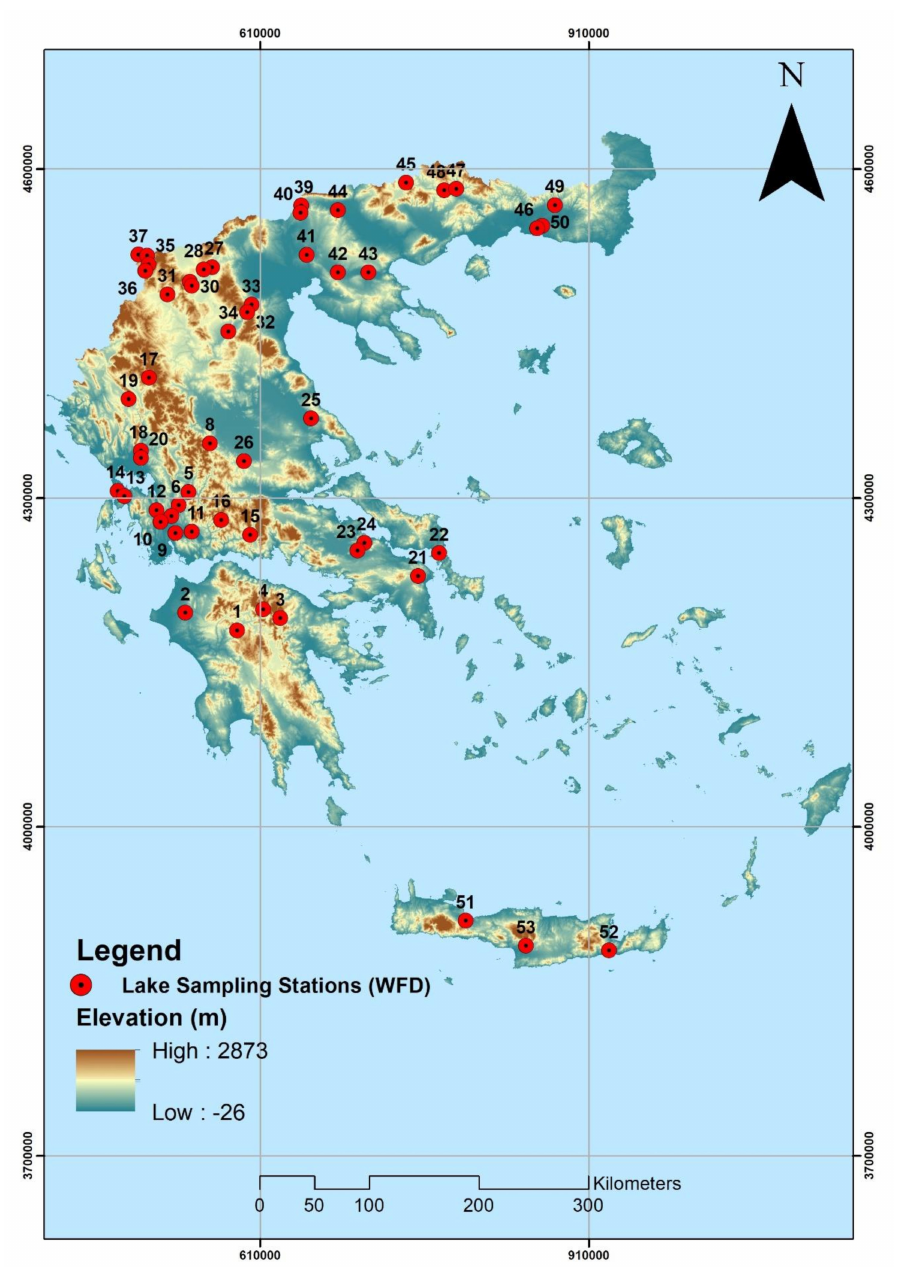
Figure 1. Monitoring network for lakes in Greece (GGRS_1987 coordinate system; Transverse Mercator projection; numbers of sampling stations coincide with the numbers presented in Table